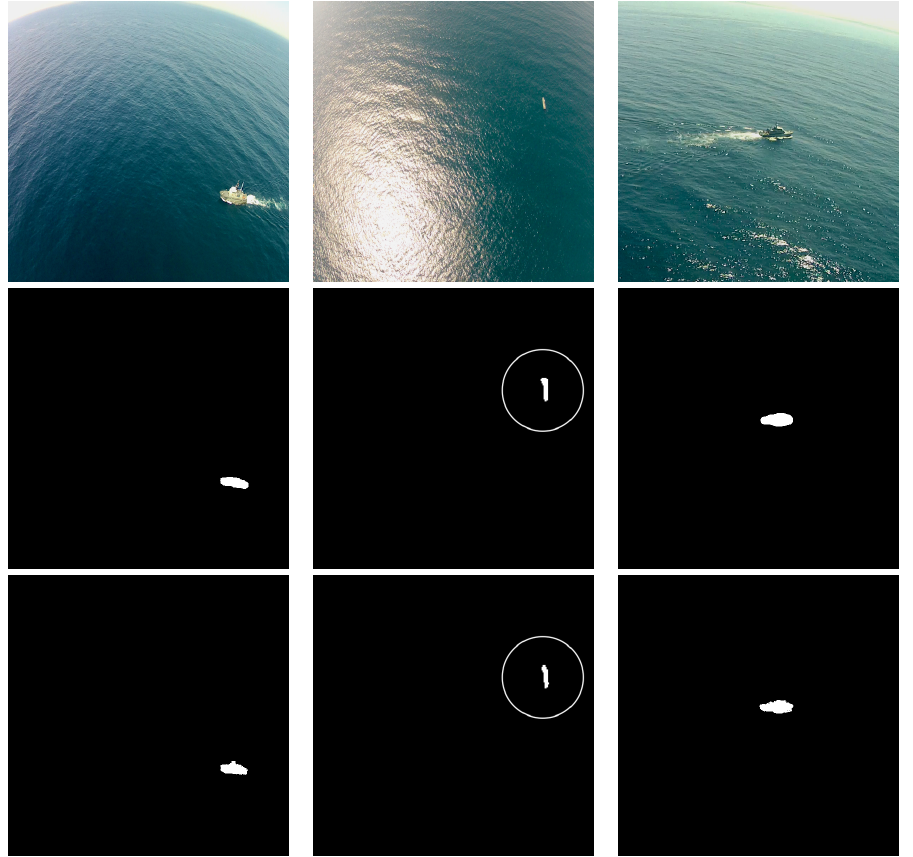
Figure 11. Qualitative evaluation on the Seagull dataset. Top row: original images; middle row: Yolact++ segmented images; bottom row: final segmentation result after post-processing with 3D CRF. Circles in the second column denote a magnified image for better visualization.